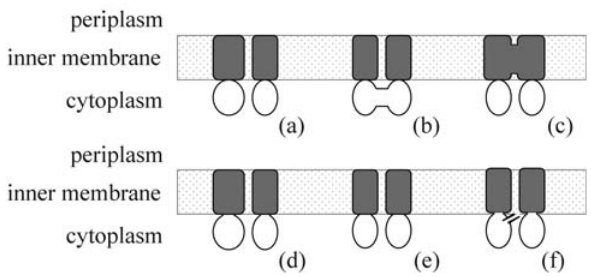
Figure 1 - Organization of ABC transporters. The typical ABC trans- porter has four domains, two membrane associated domains (IMDs, TMDs or SMD) and two ATP-binding domains (ABCs). a) In some trans- porters the four domains can be encoded as separate polypeptides ( e. g. TC# 3.A.1.5.1 OppABCDF of S. typhimurium ). In other transporters the domains may be fused in a variety of configurations: b) fused ABCs (as